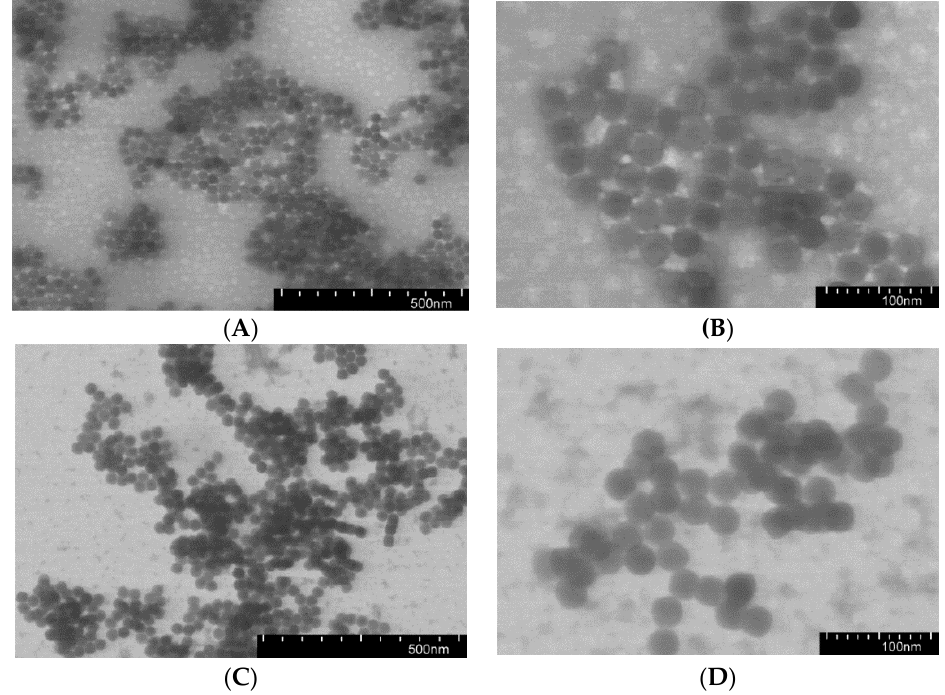
Figure 3. Transmission electron microscopy (TEM) images of P(Glu- co - D Phe) ( A , B ) and P(Lys- co - D Phe) ( C , D ) nanospheres (samples EF2 and KF2).